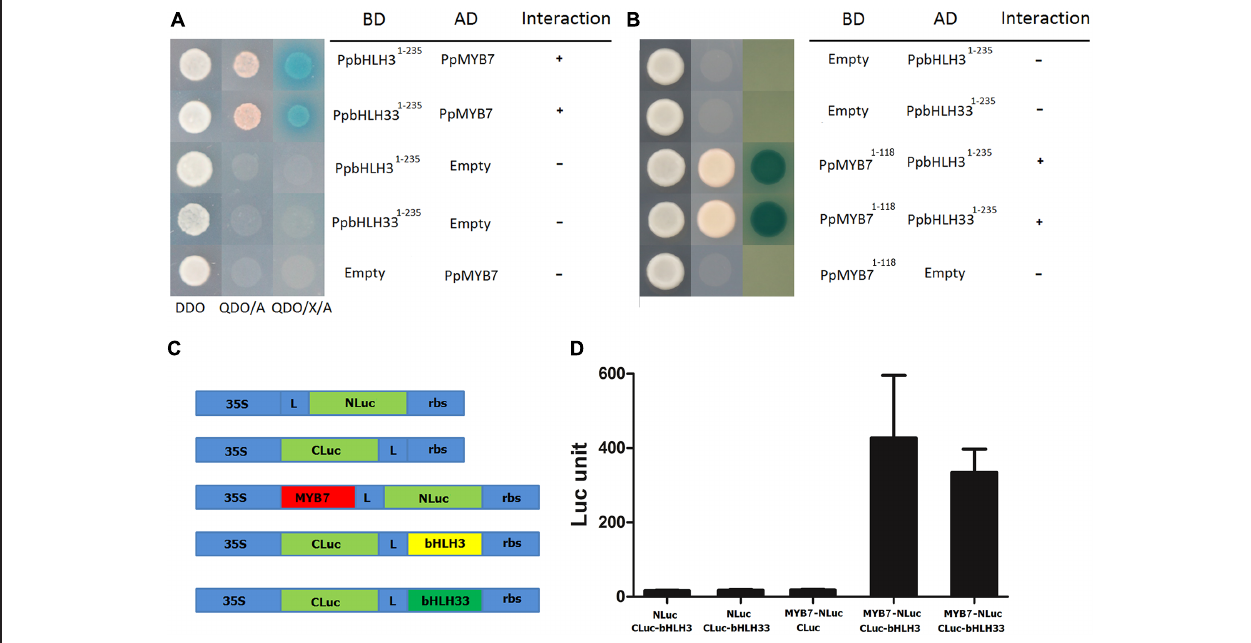
Frontiers in Plant Science | www.frontiersin.org